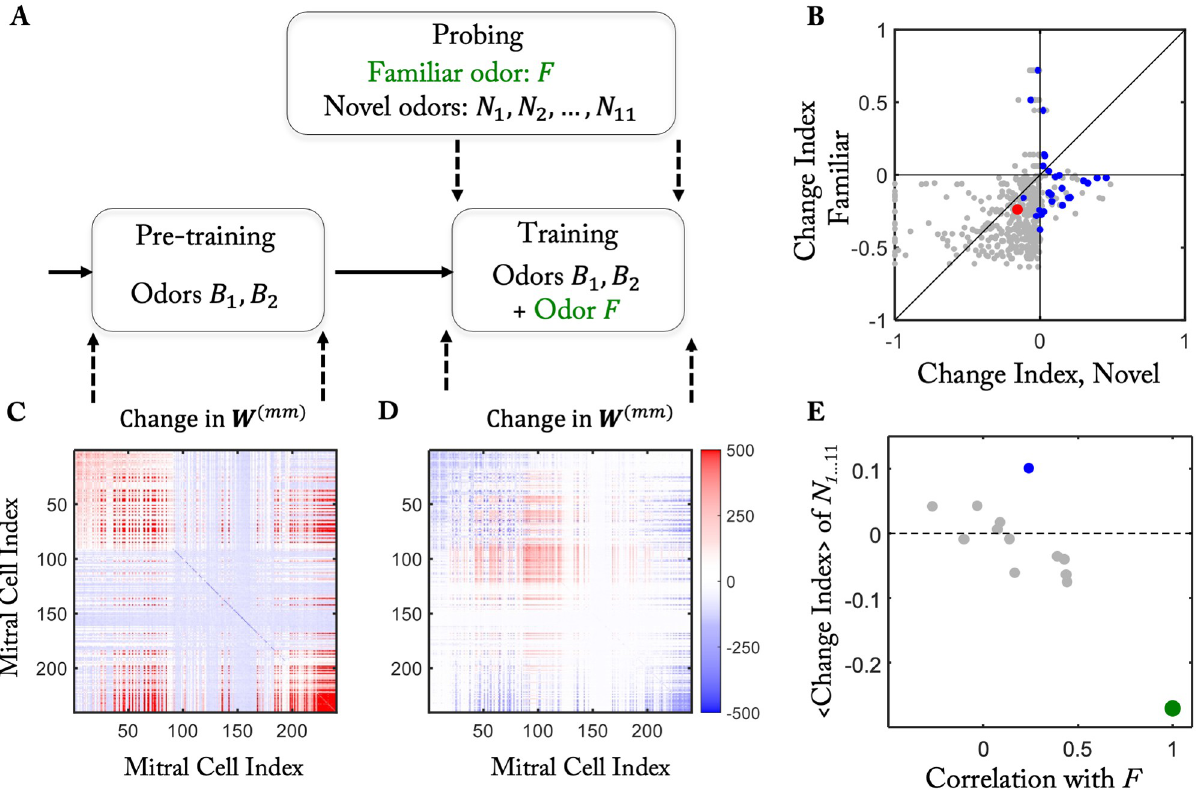
Fig 4. Odor specific adaptation (cf. [25]). (A) Simulation protocol. Pre-training with odors B 1,2 established a background connectivity. During training the network became familiar with an additional odor F . (B) The MC response to the familiar odor F is more reduced than to the novel odors N 1 ... 11 ). (C) During pre-training connections are predominantly added from GCs to MCs that are activated by the background odors B 1,2 (MC indices below 90 and above 200). The color indicates the change in W ( mm ) , i.e. in the number of GCs connecting the respective MCs. (D) During training the number of connections of MCs responding to the familiar odor F increases, but that corresponding to odors B 1,2 decreases (cf. (C)). (E) The mean change index of the novel odors N 1 ... 11 is correlated with their similarity to the familiar